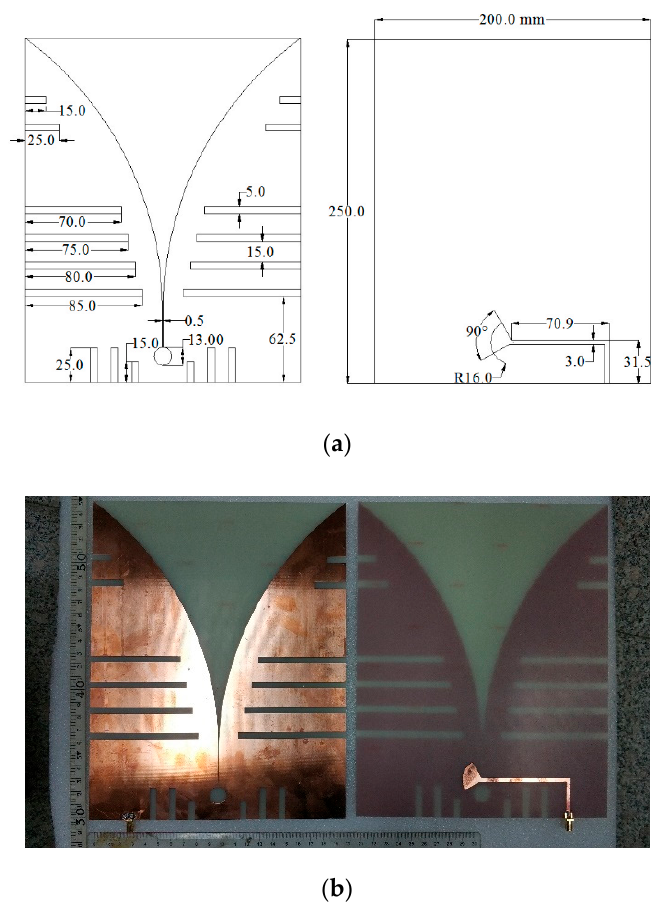
Figure 7. ( a ) Configurations of the designed Vivaldi antenna; ( b ) Top and bottom view of the manufactured Vivaldi antenna.